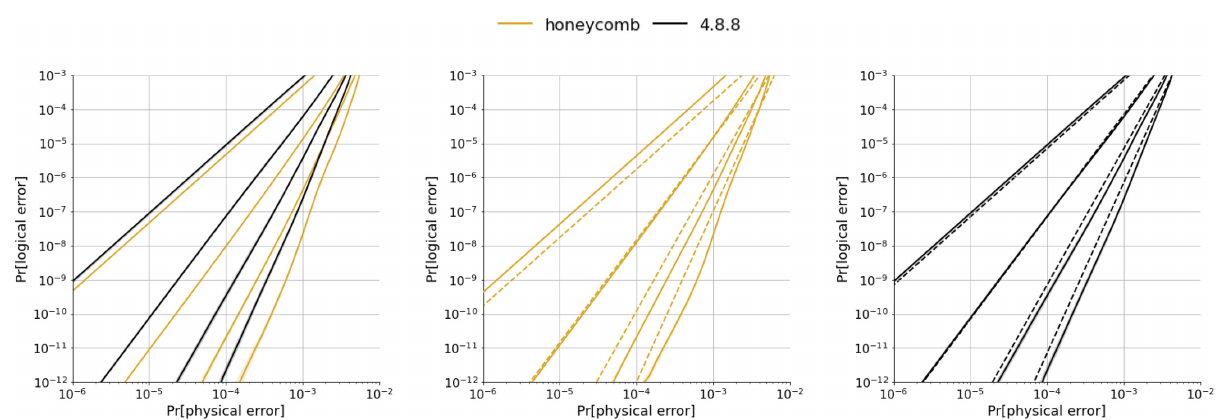
FIG. 8. (a) Empirical logical error estimates for the honeycomb and 4.8.8 Floquet codes with planar boundaries. Effective distances (3,5,7,9) are shown. (b) Heuristic estimates of 0.25 ( p / 0.012 ) ( d + 1 )/ 2 as a function of the effective distance d for the parallelogram honeycomb code. Empirical estimates are shown as solid lines for reference. (c) Heuristic estimates of 0.07 ( p / 0.01 ) ( d + 1 )/ 2 for the rectangular 4.8.8 Floquet